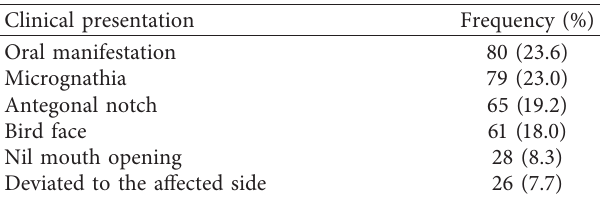
Table 4: Frequency distribution of clinical presentation of the